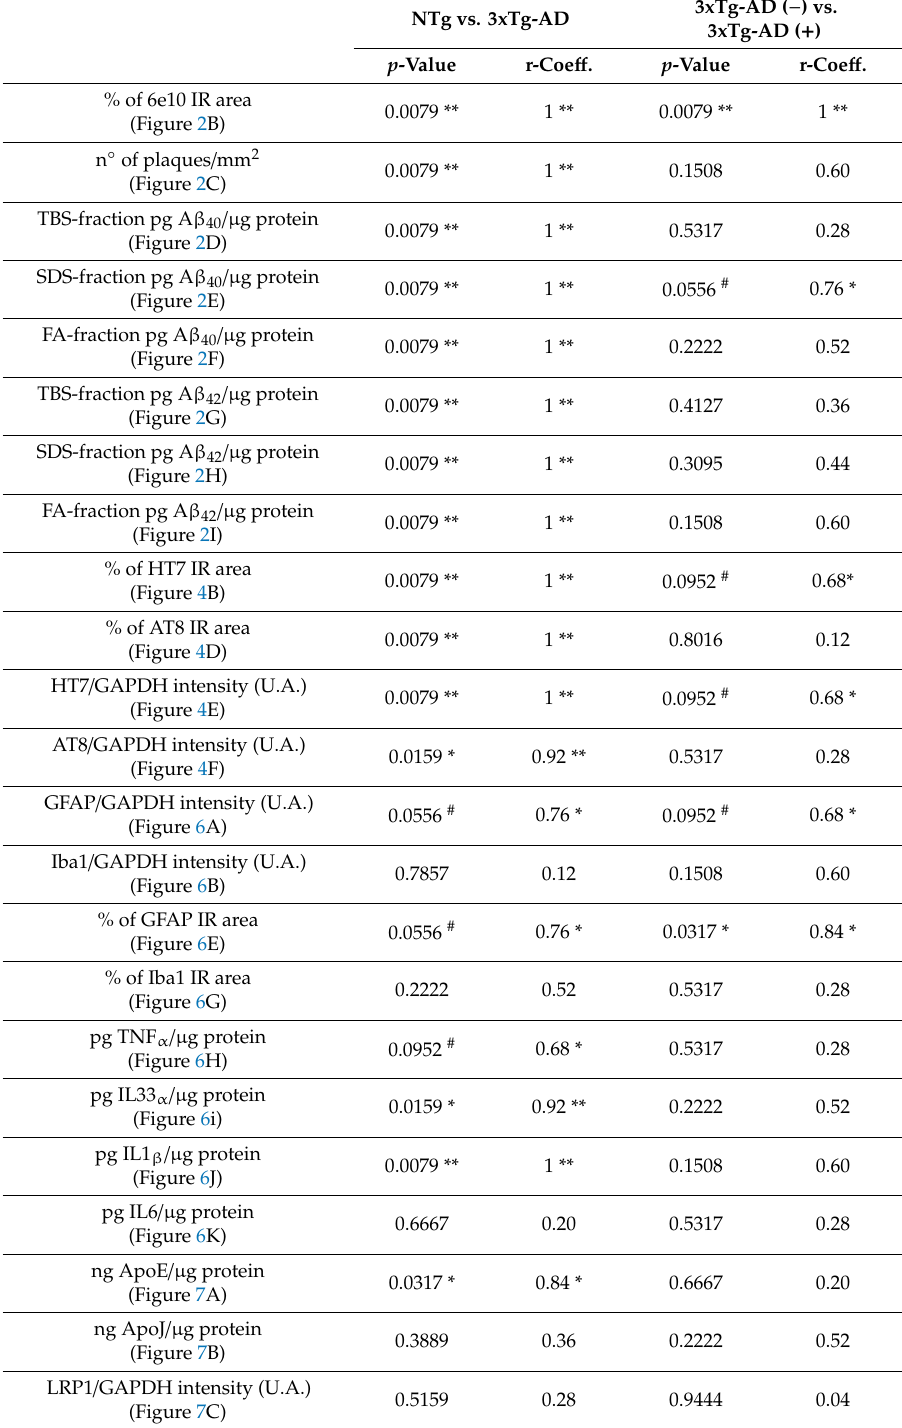
Table 1. Comparison between the p -values (Mann-Whitney U-test) and the r-coe ffi cients (using the obtained U -values in the Wendt formula [74]). Considering the size of the groups in this study ( n = 5), r-coe ffi cients ≥ 0.68 are significant at p -value ≤ 0.05, whereas values ≥ 0.92 (more restrictive because the r-coe ffi cient ranges from 0 to 1) are significant at p -value ≤ 0.05 to p ≤ 0.01